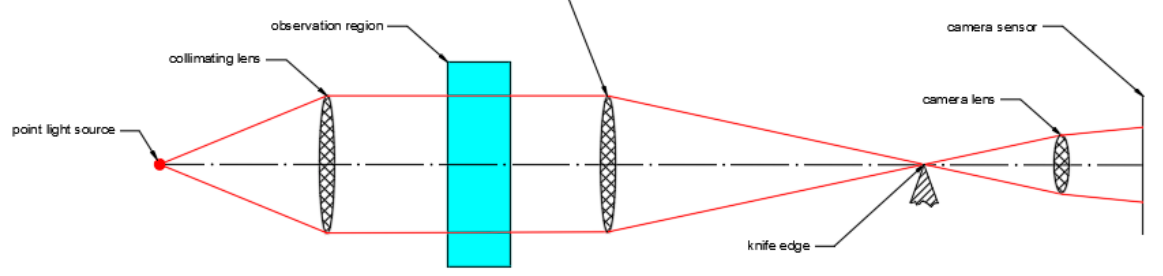
Figure 17. Basic Schlieren layout with camera.